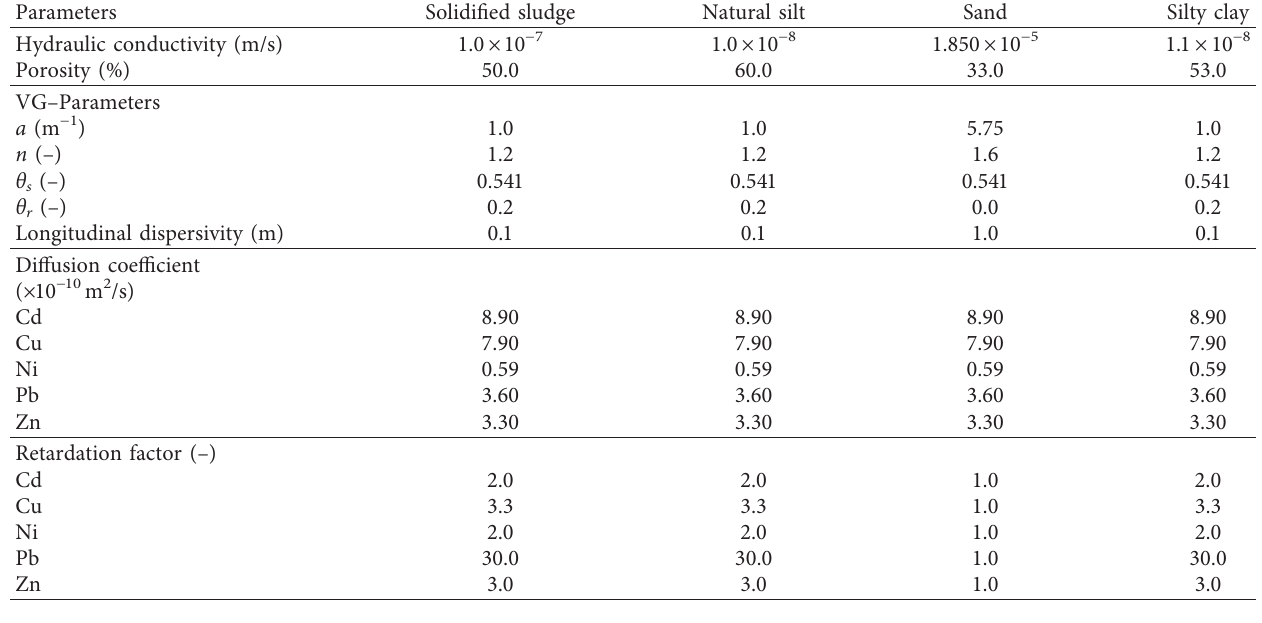
Table 2: Parameters of the calculation model.